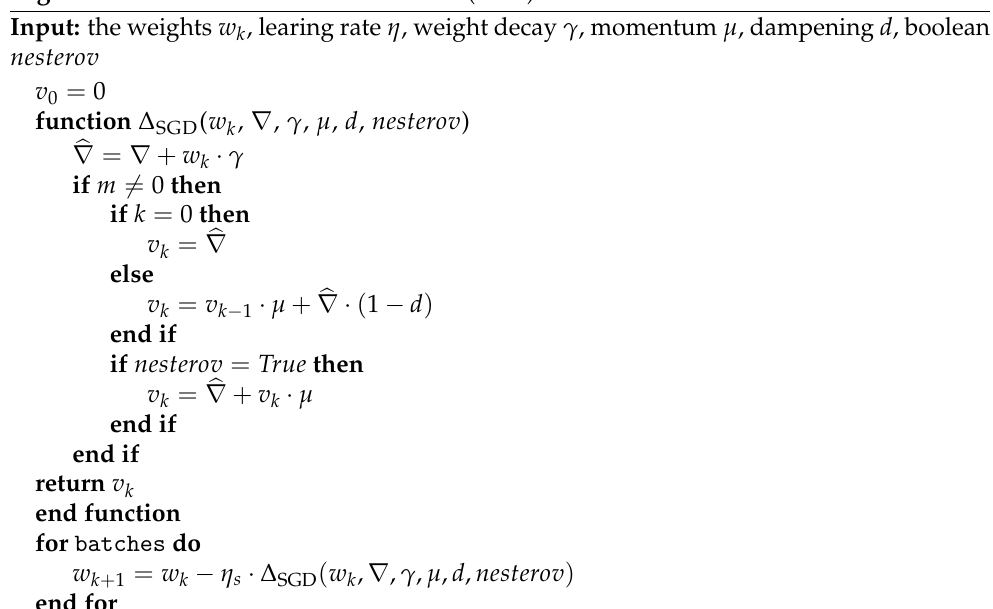
Algorithm 1 Stochastic Gradient Descent